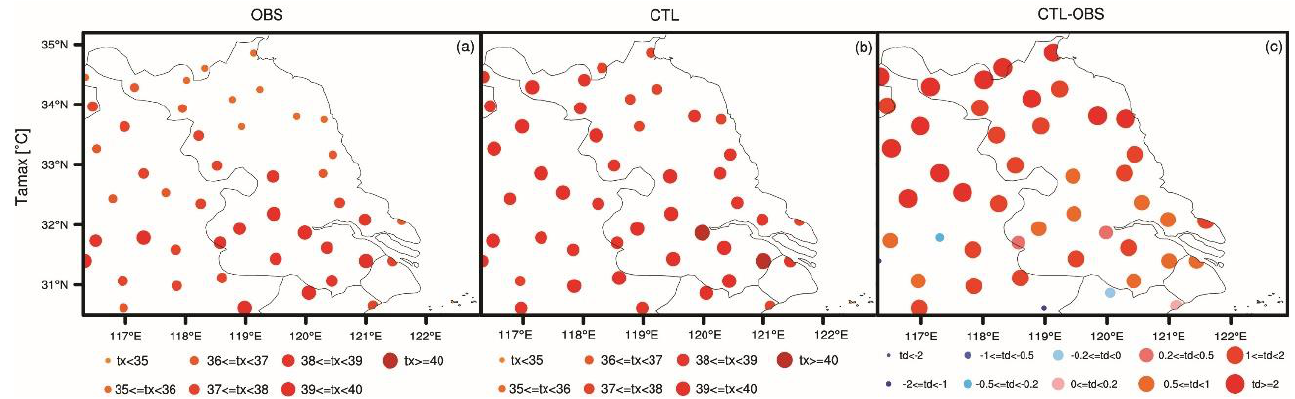
Figure 4. ( a ) Daily averaged observed air temperature, ( b ) simulated air temperature, and ( c ) their difference (unit: °C) over the research period in EC.